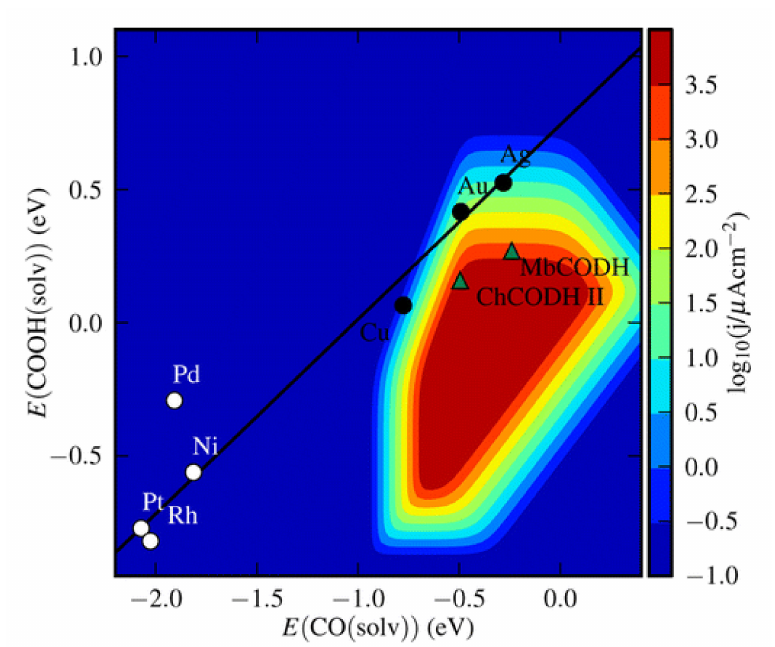
Figure 7. Kinetic volcano at 0.35 V overpotential for CO propagation from the transition metal (211) stage. The transition metals follow a linear trend that does not cross over the peak of the volcano. The noble metals, on the other hand, reach the trend line’s optimum. The specific CO generation current from the ChCODH II and MbCODH enzyme models is comparable to, if not superior to, that of the noble metals. Reprinted with permission from [54]. Copyright 2014, American Chemical Society.